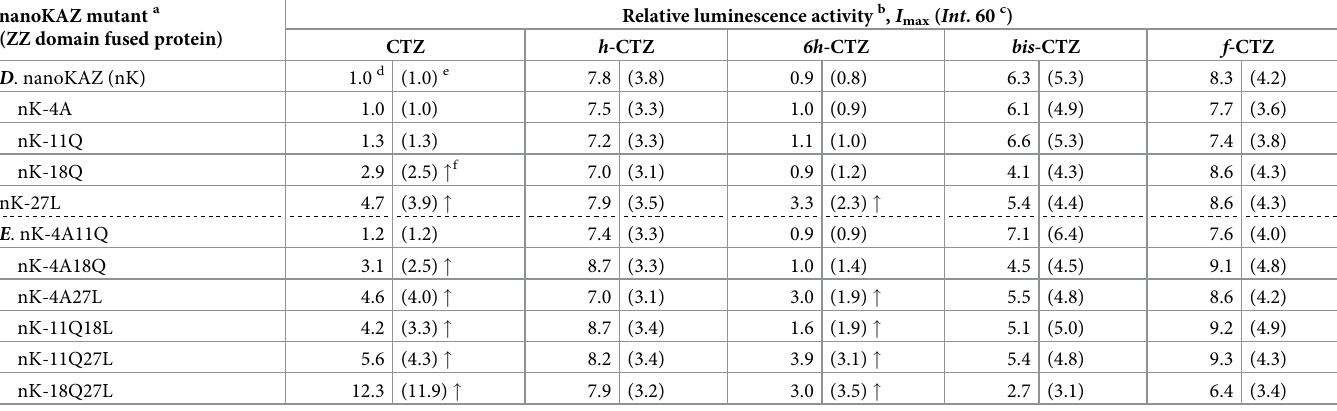
Table 2. Luminescence activities of reverse mutants of nanoKAZ using coelenterazine (CTZ) and CTZ analogs as a substrate. nanoKAZ mutant